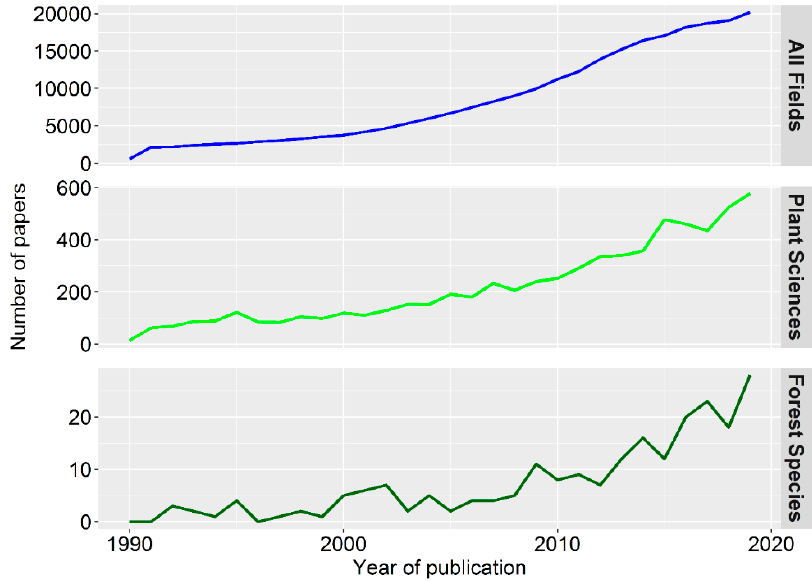
Figure 2. The number of papers on Epigenetics published per year from 1990 to 2019 (2020 being underway) in three Research Areas: all fields, plant sciences, and forest species. The number of studies was obtained from the Web of Science Core Collection (www.webofknowledge.com) with the topic search (TS) “epigenetics” and its variants (e.g. “epigenomics”). The main mechanisms behind epigenetics (DNA methylation, histone modification, chromatin remodeling, and non-coding RNA mechanisms) were also considered. An advanced search was therefore conducted as follows: TS = (epigen* OR DNA methyl* OR histone OR chromatin remodel* OR (epigen* AND RNA)). All documents written in English and part of the Science Citation Index Expanded were examined. Results were then refined to retain the papers from the “Plant Sciences” Web of Science Category (adding “AND WC = Plant Sciences” to the query). Data was further filtered for epigenetic research in forest tree species by adding TS fields of “forest” and of the main forest tree genera studied ( Picea /spruce, Pinus /pine, Populus /poplar, Quercus /oak, and Eucalyptus /eucalypt) and avoiding results referring to the “random-forest” method (NOT TS = random forest).